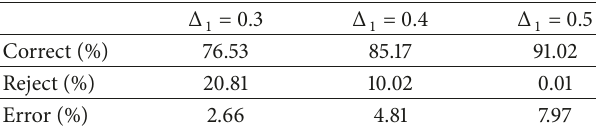
Table 2: The results of Fuzzy Control Systems with TF ⋅ ICF